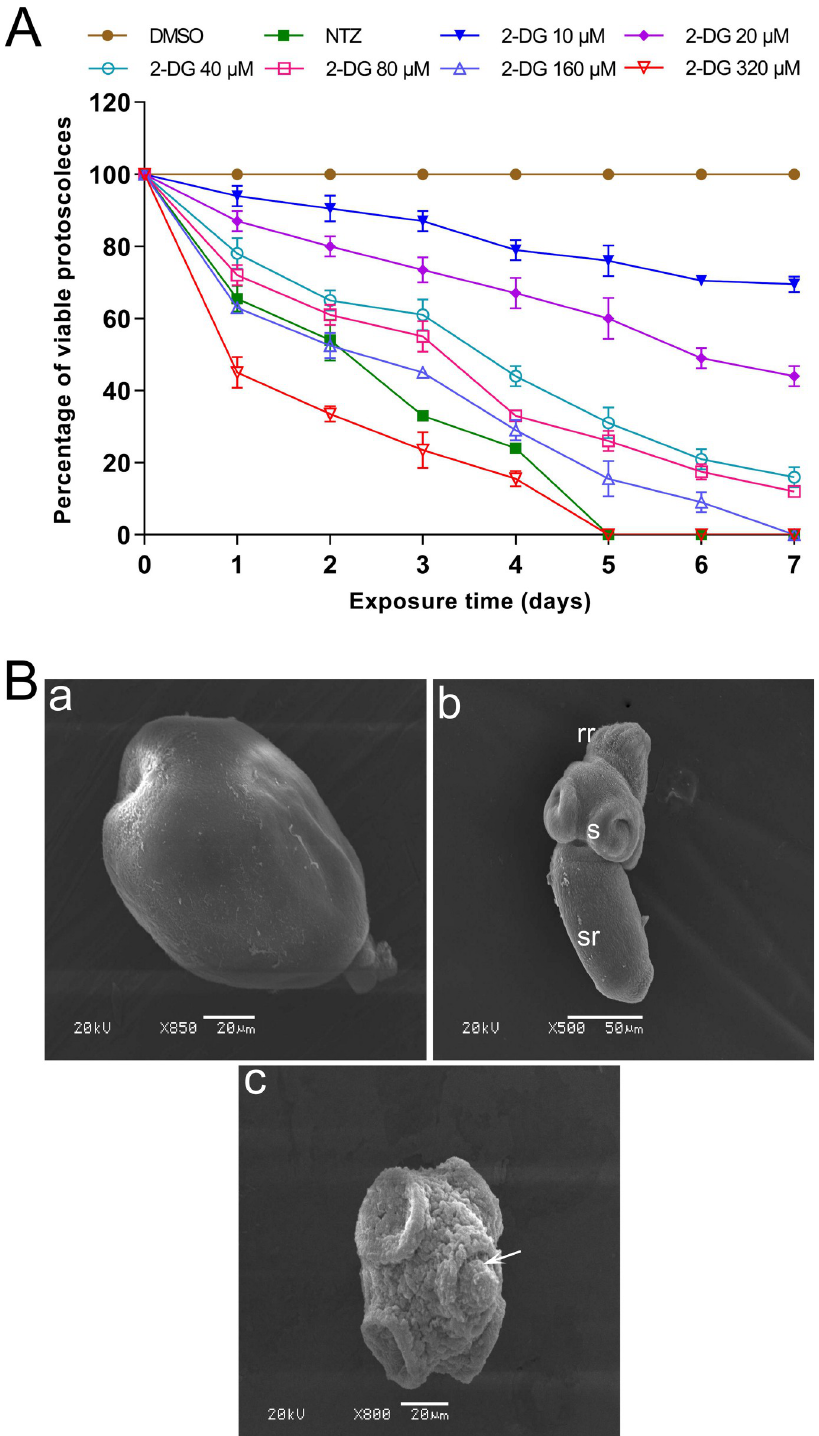
Fig 1. In vitro effect of 2-DG against E . granulosus protoscoleces. (A) Viability of protoscoleces incubated for 7 days with 40 μ M NTZ or serial concentrations of 2-DG (10, 20, 40, 80, 160, and 320 μ M). Protoscoleces incubated in a culture medium containing 0.2% DMSO were used as a control. (B) Scanning electron microscopy of protoscoleces after 5 days of incubation. (a) Invaginated control protoscoleces; (b) Evaginated control protoscoleces (rr, rostelar region; s, suckers; sr, soma region); (c) Protoscoleces incubated with 40 μ M 2-DG. Protoscoleces showed marked contraction, shedding of microtriches and loss of hooks (arrow). https://doi.org/10.1371/journal.pntd.0010618.g001 PLOS NeglectedTropical Diseases | https://doi.org/10.1371/journal.pntd.0010618 July 18,